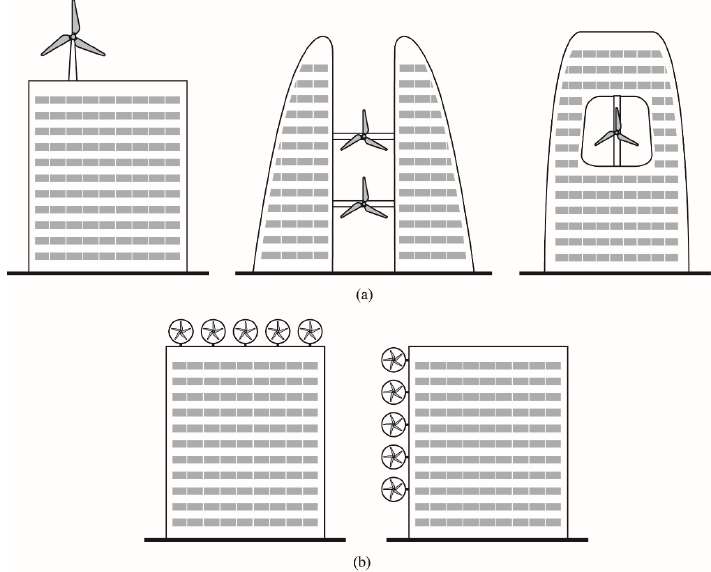
Figure 1. Building-integrated wind turbine system using wind turbines: ( a ) three possible installation locations of large-size wind turbines; and ( b ) two possible installation locations of small-size wind